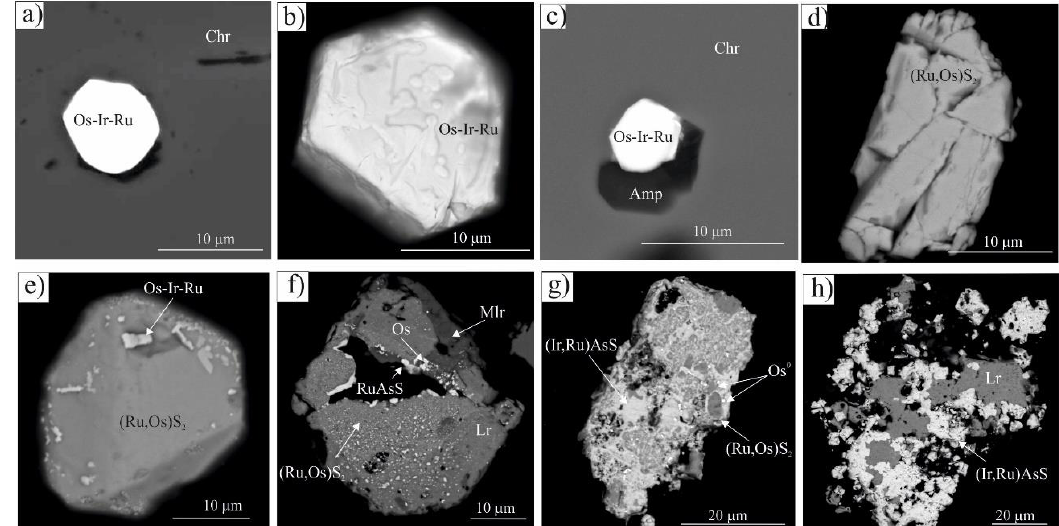
Figure 9. Back Scattered Electron ( BSE) images of primary PGM, showing the textural and morphological relations of single and polyphase PGM from the Ulan-Sar’dag chromitites: ( a ) inclusion euhedral Os-Ir-Ru alloy—I in chromite, an. 1; ( b ) individual single-grain Os-Ir-Ru alloys—I, with a dissolution microstructure, an. 2; ( c ) inclusion in Cr-spinel of intergrowth laurite I and hornblende, an. 6; ( d ) individual grain of laurite I, an. 7; ( e ) grain of laurite II (an. 8), with inclusions of micro particle Os-Ir-Ru alloys—II; ( f ) grain laurite II (an. 9), associated with an unnamed phase (Ru,Ni,Os,Ir,Rh)AsS (an. 36) (laurite II is surrounded by Os-poor laurite, which grows with millerite); ( g ) substitution of laurite II by irarsite (an. 32), with remnants of laurite II (an. 10,11) and Os-Ir-Ru alloys—II; ( h ) laurite II (an. 12) surrounded by irarsite (an. 33). Abbreviations: Crsp—chrome spinel; Lr—laurite; Mlr—millerite. Notes: an. No—No analysis, as shown in Table 4.